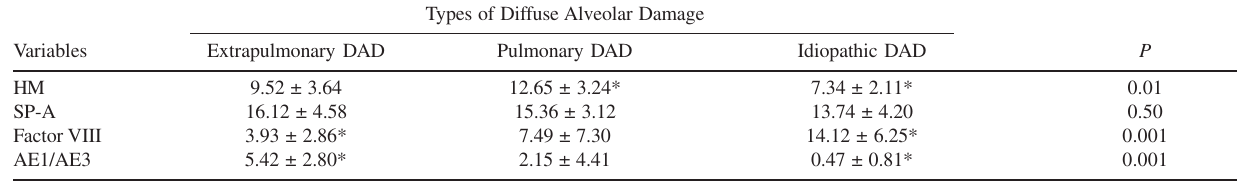
Table 1 - Results of the statistical analysis of the quantitation of hyaline membrane (HM) and the 3 antigens that showed immunohistochemical positivity among the 3 groups of patients with DAD (mean + SD) Types of Diffuse Alveolar Damage